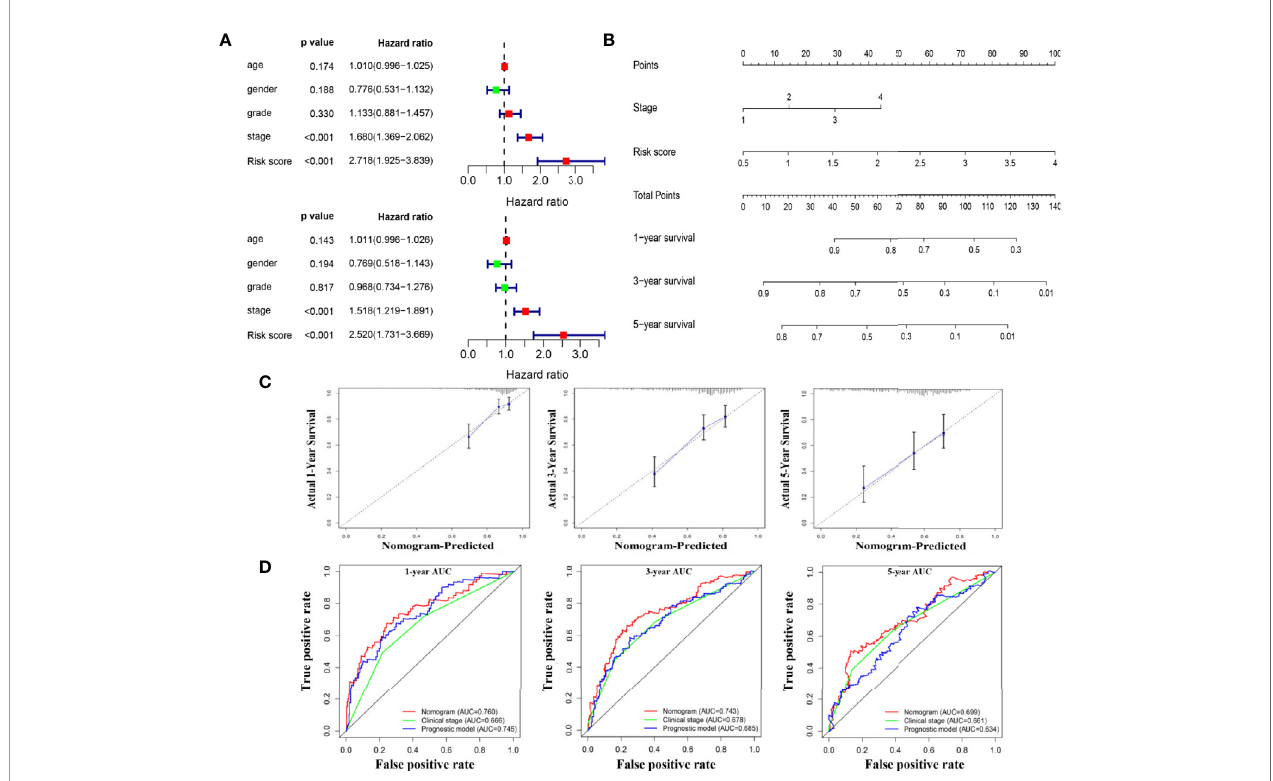
FIGURE 9 | A nomogram for overall survival prediction for HCC patients. (A) Univariate and multivariate Cox analyses for the prognostic model and clinical parameters. (B) . A nomogram to predict OS at 1 year, 3 years, and 5 years of patients with HCC. (C) . Calibration plots showing the prediction of OS at 1 year, 3 years, and 5 years by the nomogram (D) . Comparison of time-dependent ROC curves among nomogram, clinical stage and the prognostic